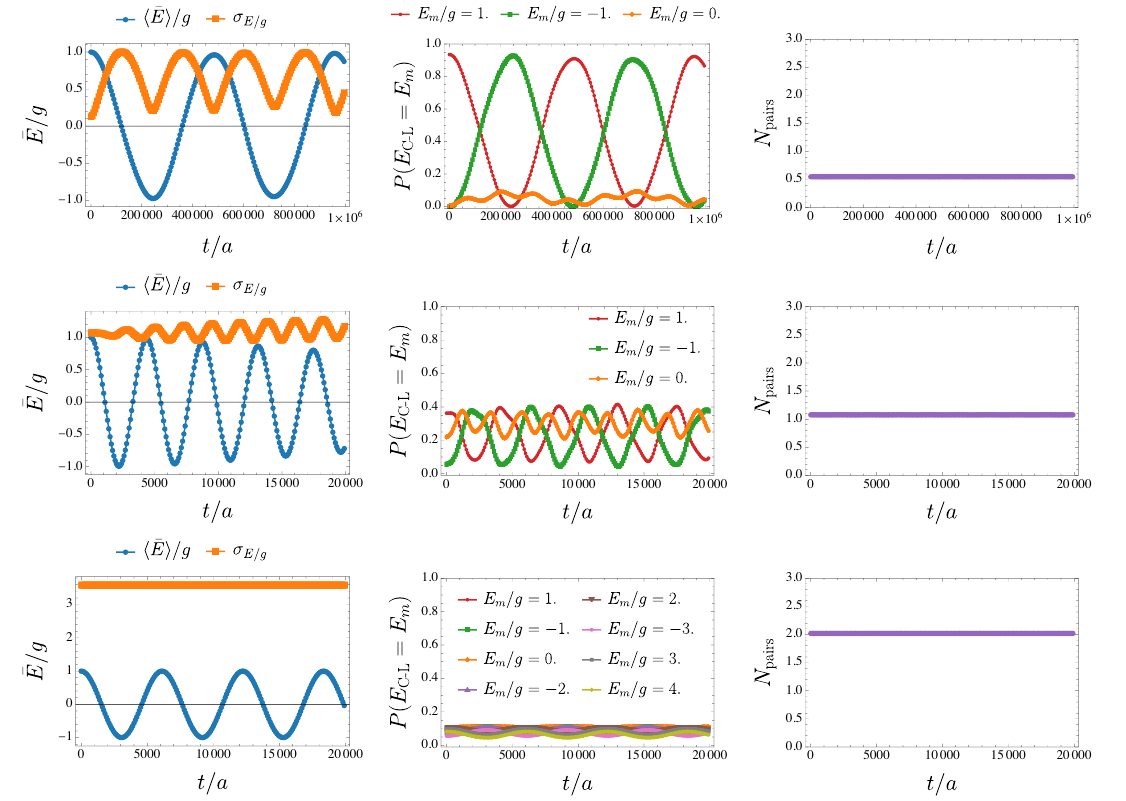
(cid:10) ¯ (cid:11) Figure 3. The expectation values of the spatially averaged electric field E /g , the standard deviation of the spatially averaged electric field σ , the probability to measure field E on the m E/g central link P ( E = E ) , and the number of electron-positron pairs N as functions of time C-L m pairs in the k = 2 quench for m = 50 , with three different spatial circle sizes mL = 8 (top panel), g mL = 4 (middle panel) and mL = 1 (bottom panel) on an N = 10 lattice. For the same reason as in figure 2, we set l = 10 for mL = 8 , 4 simulations and l = 30 for mL = 1 max max